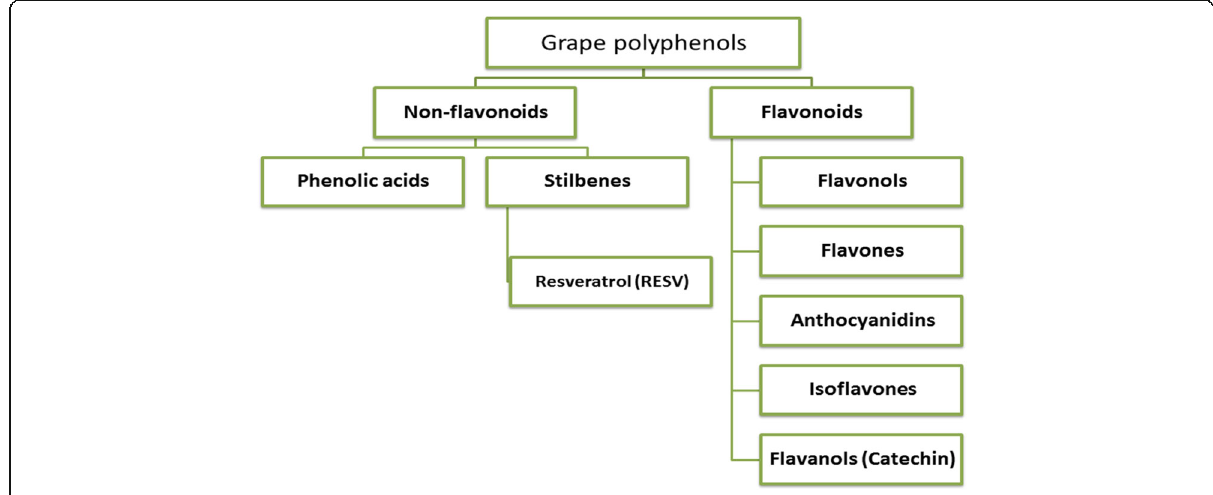
Fig. 1 Classification of grape